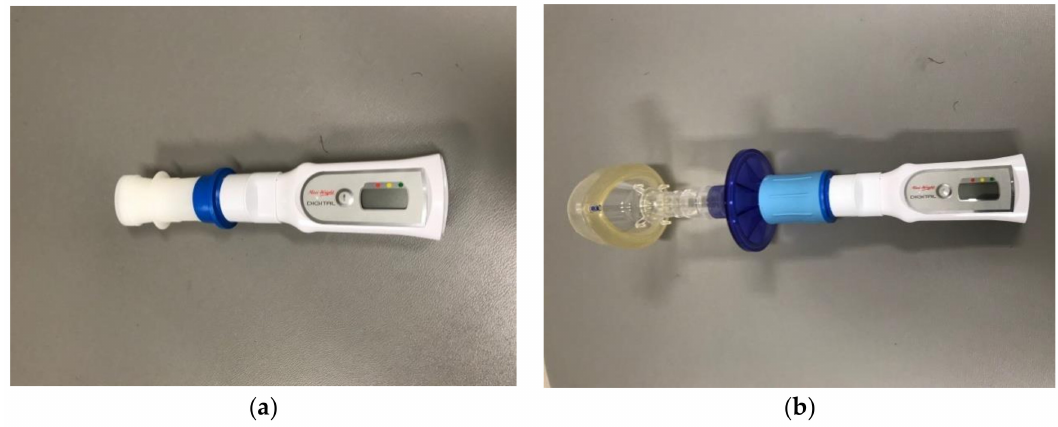
Figure 1. Peak flow meter used to measure peak cough flow in children with neuromuscular disease (NMD): ( a ) with mouthpiece; ( b ) with